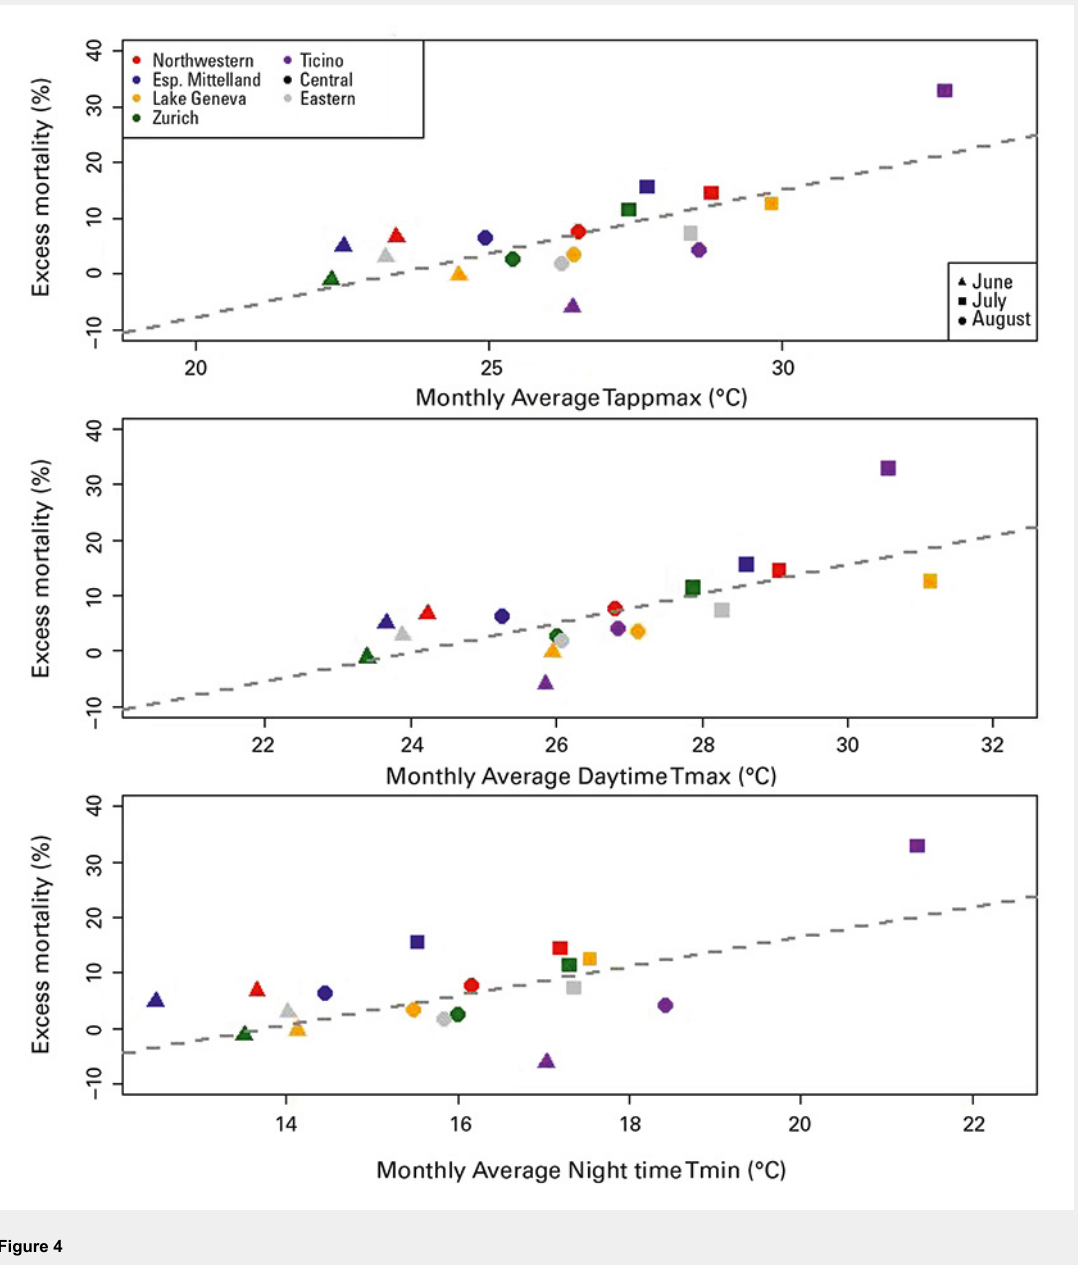
Figure 4 Relationship between monthly average temperature and estimated excess mortality (%) in each great region. Daytime Tmax = daytime maximum temperature; Night time Tmin = night-time minimum temperature; Tappmax = maximum apparent